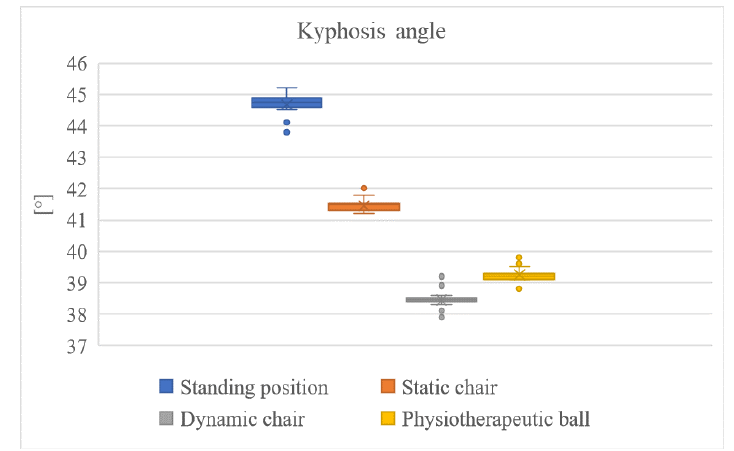
Figure 10. Range of values of the followed body parameters. The diagram in Figure 11 depicts the value range of the lower back lordosis depth. The lowest values of the lower back lordosis were measured during sitting on a physiother- apeutic